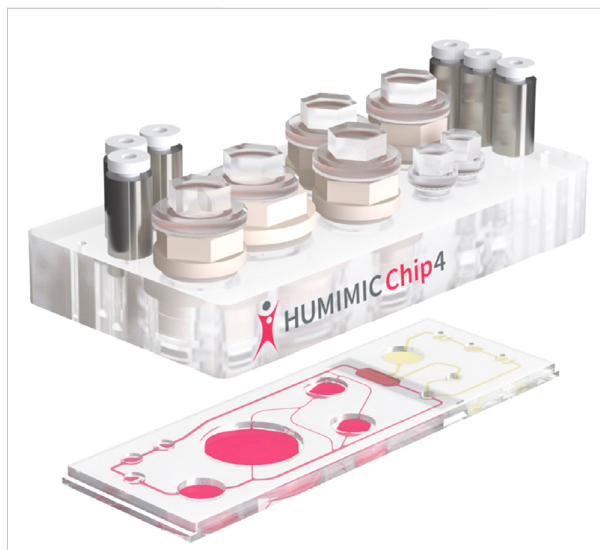
FIGURE 2 HUMIMIC Chip exploded view. The author is grateful to TissUse GmbH for permission to use Figure 2 under License: CC BY-ND